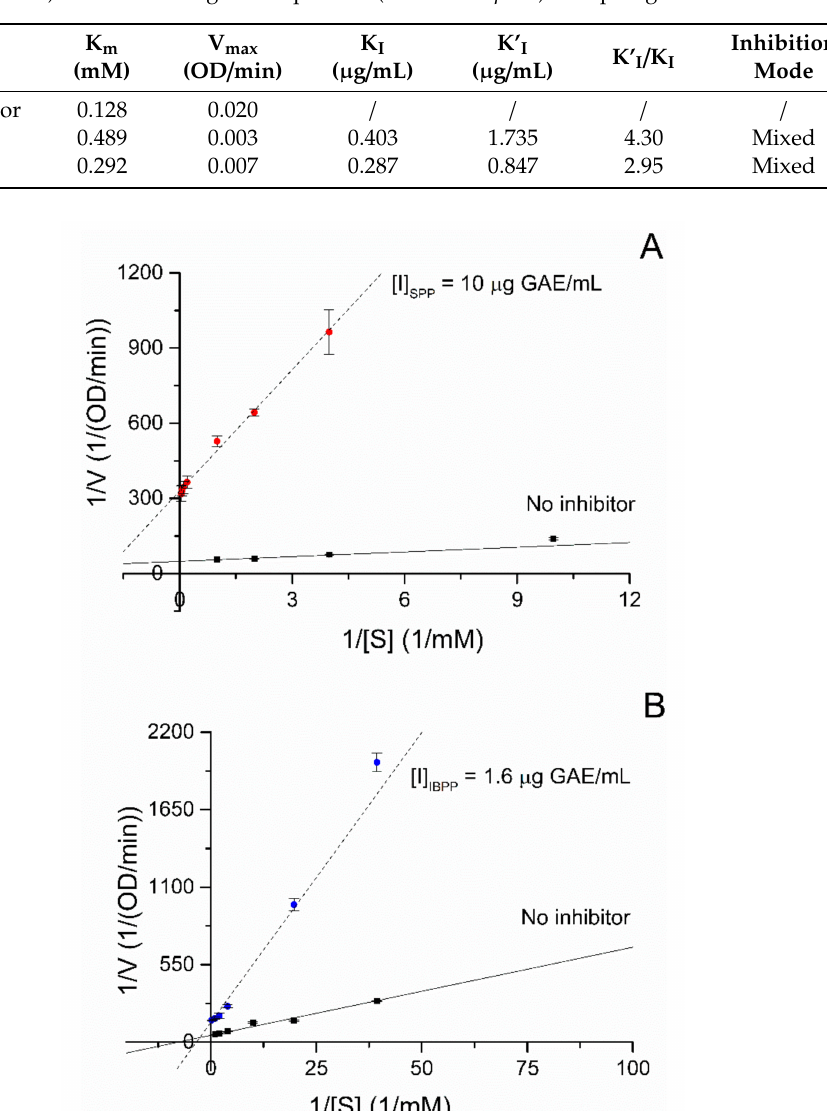
Figure 3. Enzyme kinetics analysis of both polyphenol fractions on alpha-glucosidase. ( A ) Lineweaver– Burk plot of the SPP fraction. ( B ) Lineweaver–Burk plot of the IBPP